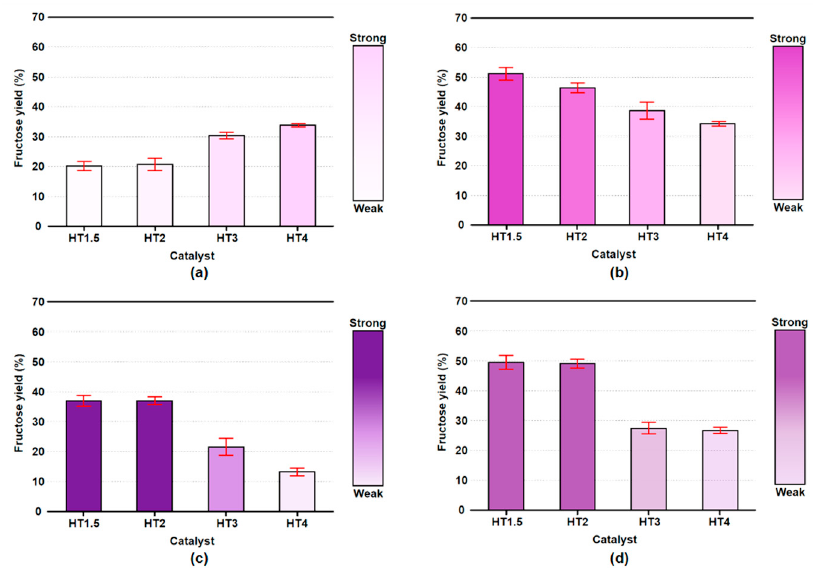
Figure 6. Relationship between fructose yield and the base properties of HTX (X = 1.5, 2, 3, and 4) catalysts as determined using the phenolphthalein indicator in various solvents: ( a ) water, ( b ) MeOH, ( c ) DMSO, and ( d ) DMF.